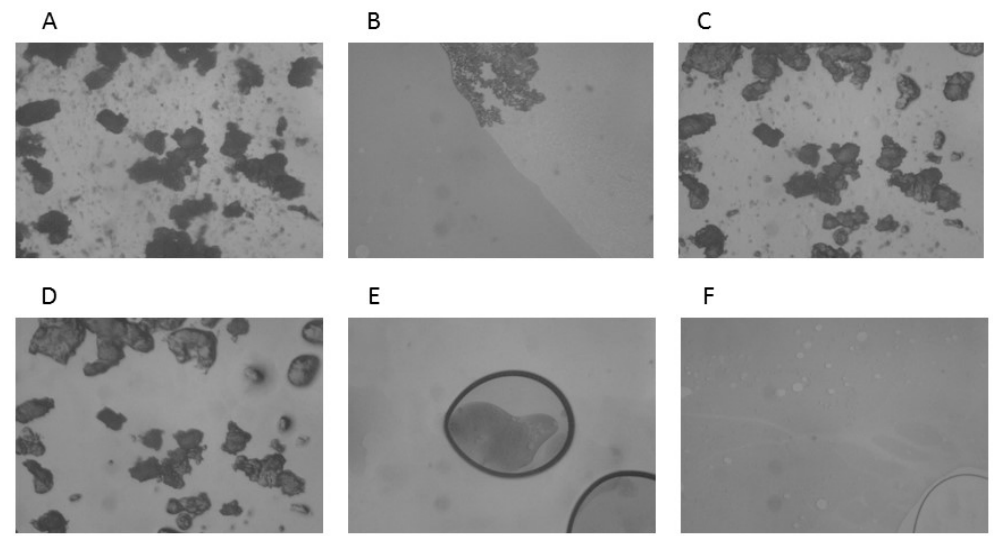
Figure 4. HSM micrographs for ABZ-PU particles at different temperatures: ( A )—ABZ-PU at 25 °C; ( B )—ABZ-PU at 25 °C—back cooled product; ( C )—ABZ-PU at 160 °C—some particles melted; ( D )— ABZ-PU at 230 °C—melting starts for other particles; ( E )—ABZ-PU at 245 °C—melted; ( F )—ABZ-PU at 250 °C—melted. The magnification in the photographs was 59.7×.